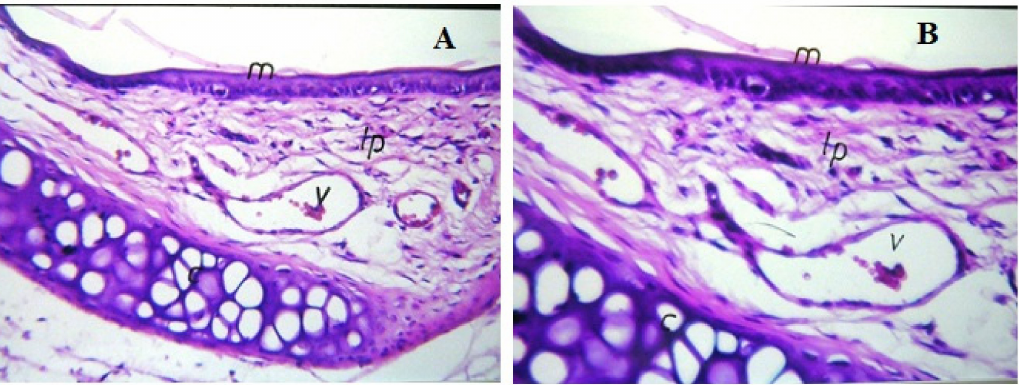
Figure 10. Light photomicrographs of the rat nasal mucosa following 14-day exposure to olan- zapine PM ( A ) and control untreated animal ( B ) m, mucosa; v, vessel; lp, lamina propria; c, cartilaginous layer.